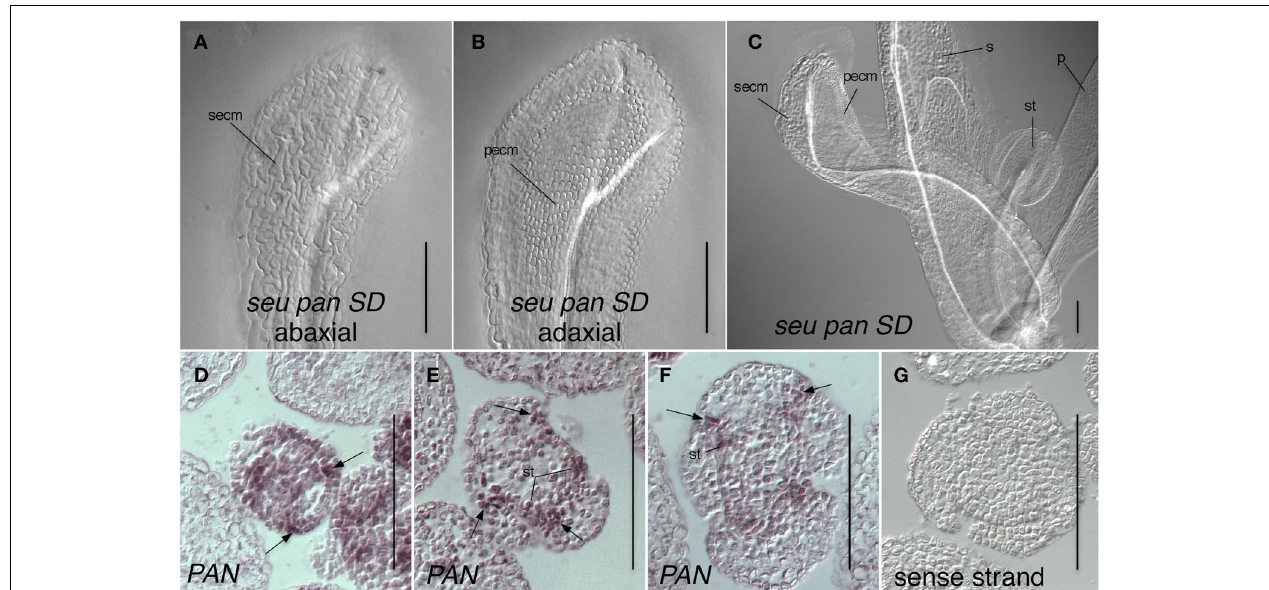
FIGURE 6 | Expression of PAN in adaxial portions of sepals is consistent with a role for PAN in the repression of AG and specification of organ identity. (A–C) Differential interference contrast optics microscopic image of chloral hydrate cleared tissue. (A) Abaxial surface of whorl one organ in seu pan short-day (SD)-grown flower displays cells with sepal epidermal cell morphology (secm). (B) Adaxial surface of same organ as in panel (A) displays petal epidermal cell morphology (pecm). (C) A seu pan flower displays a partial homeotic transformation of whorl one organ on adaxial surface as indicated by the